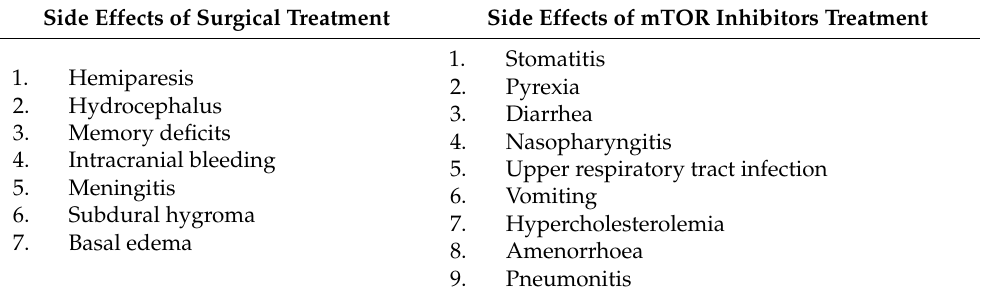
Table 1. Most common side effects of surgical and medical treatments of